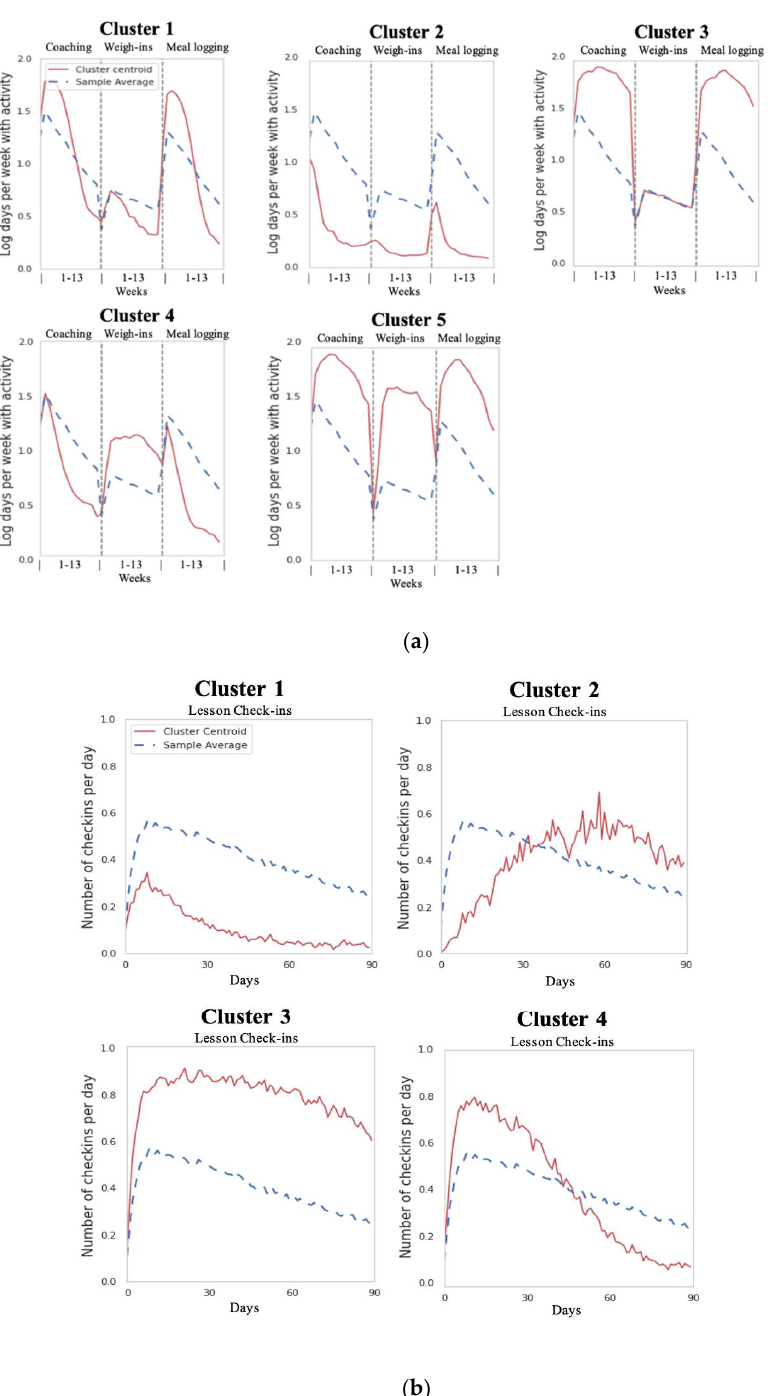
Figure 1. ( a ) Five concatenated univariate app-feature clusters showing log-scaled days per week (y-axis) with activity for coaching exchanges, weigh-ins, and meal logging over 13 weeks in the digital DPP (x-axis). Key (top left panel): Cluster centroids shown in red lines and sample average in blue, dotted lines. ( b ) Four program-feature clusters showing daily check-ins (y-axis) with educational lessons over the 90 days (x-axis) in the digital DPP. Key (top left panel): Cluster centroids shown in red lines and sample average in blue, dotted